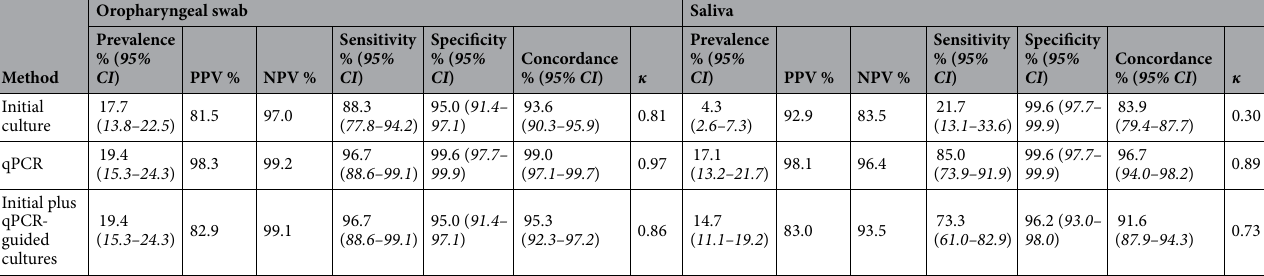
Table 2. The accuracy of genogroupable Neisseria meningitidis detection in oropharyngeal and saliva samples collected from 299 students and tested with culture and using molecular methods applied to DNA extracted from culture-enriched samples. Measures of diagnostic accuracy were calculated by comparing the number of detected individuals positive per method with the overall number of individuals positive for genogroupable N. meningitidis . PPV positive predictive value, NPV negative predictive value, 95% CI 95% confidence interval, κ Cohen’s Kappa where ≤ 0, 0.01–0.20, 0.2–0.40, 0.41–0.60, 0.61–0.80, > 0.81 are interpreted as no agreement, none to slight, fair, moderate, strong, and almost perfect agreement,